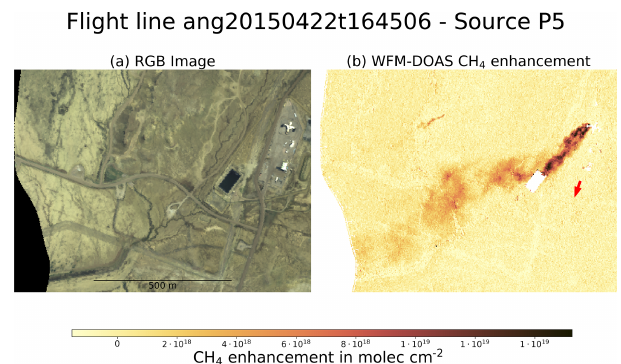
Figure 10. Similar to Fig. 8 but for the exhaust plume of a coal mine ventilation shaft in the Four Corners